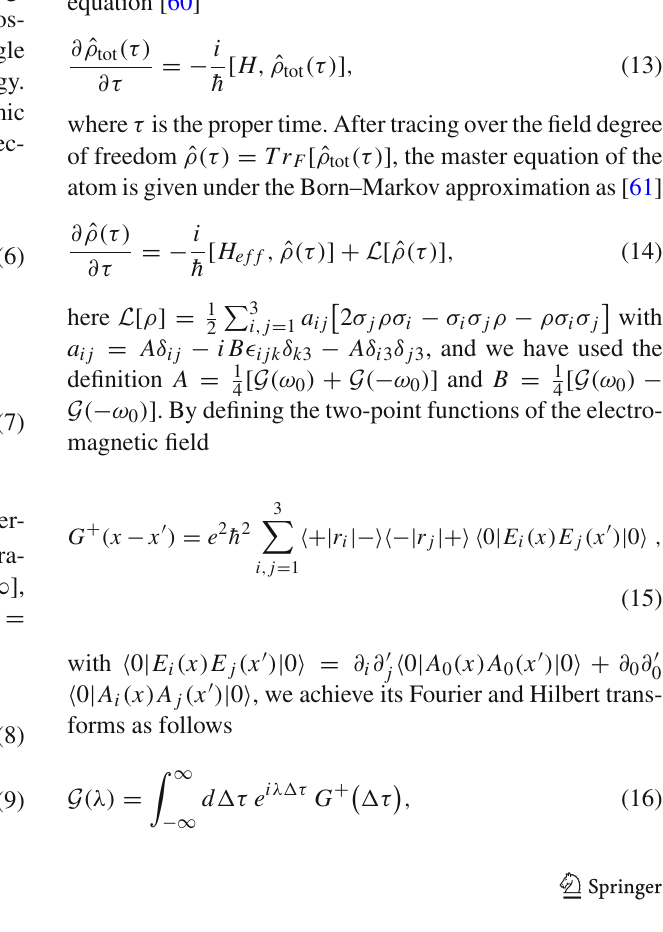
As shown in Fig. 1, in the cylindrical coordinates the cosmic string spacetime is supposed to have an string lies along the z